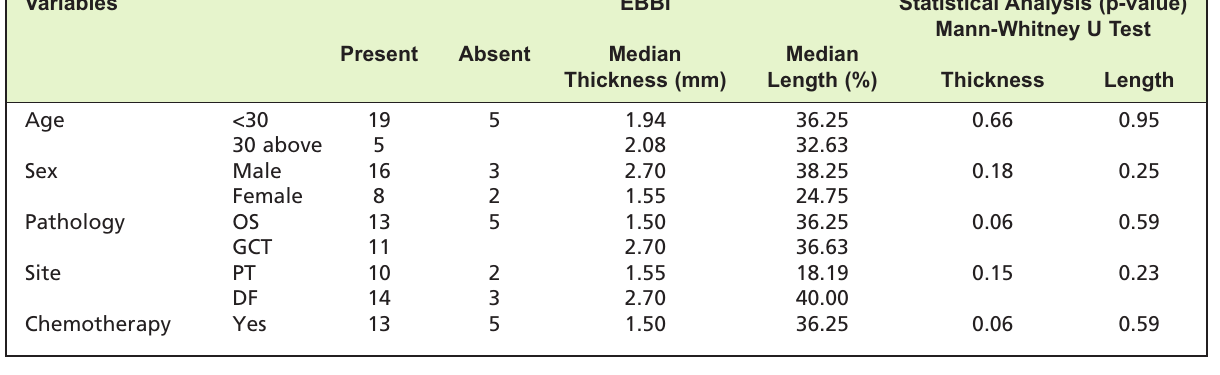
Table showing the variables that affect the AOFAS score Table I: Variables EBBI